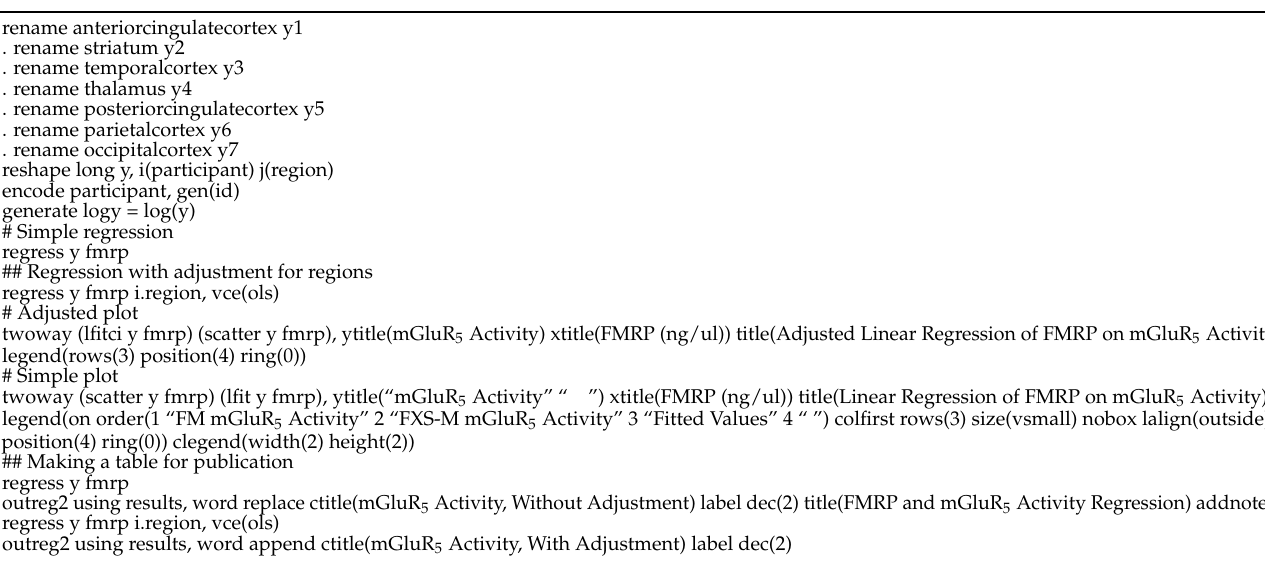
Table 6. Code to adjust linear regression of mGluR 5 expression and FMRP utilizing seven cortical and subcortical regions affected in neurodegenerative disorders as indicator variables